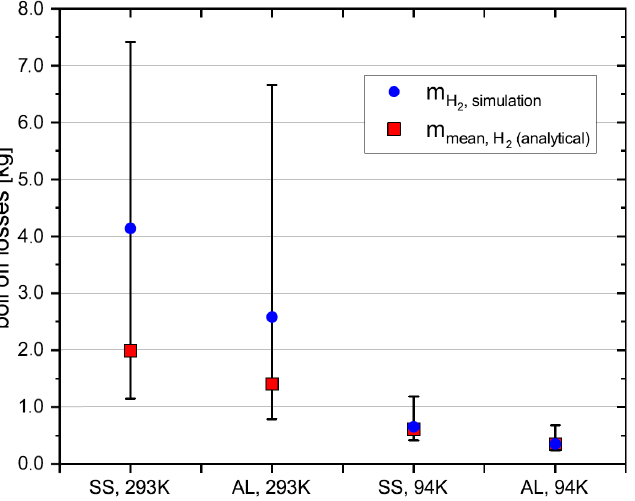
Figure 13. Comparison of the results of the simulation and the analytical